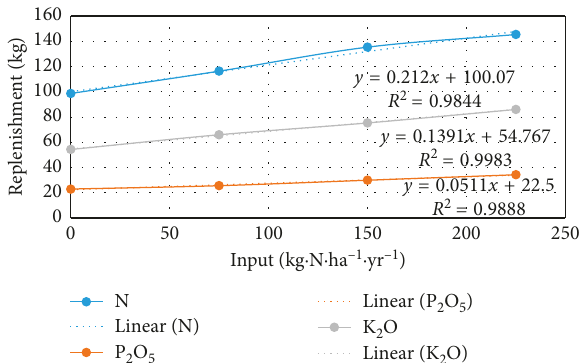
Figure 1: Soil nutrient replenishment model for Timbilil.